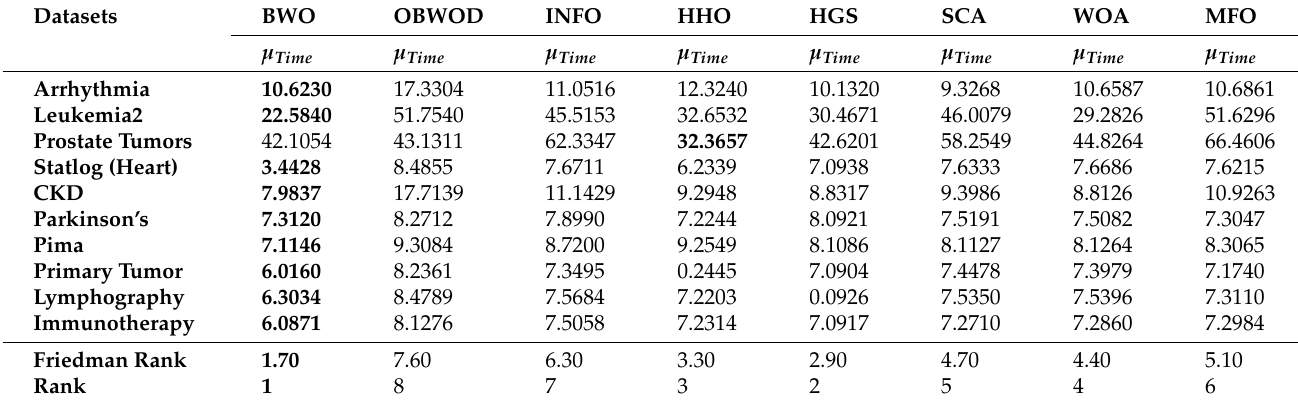
Table 13. Comparison of the time consumption between OBWOD and the other optimization algorithms based on the kNN